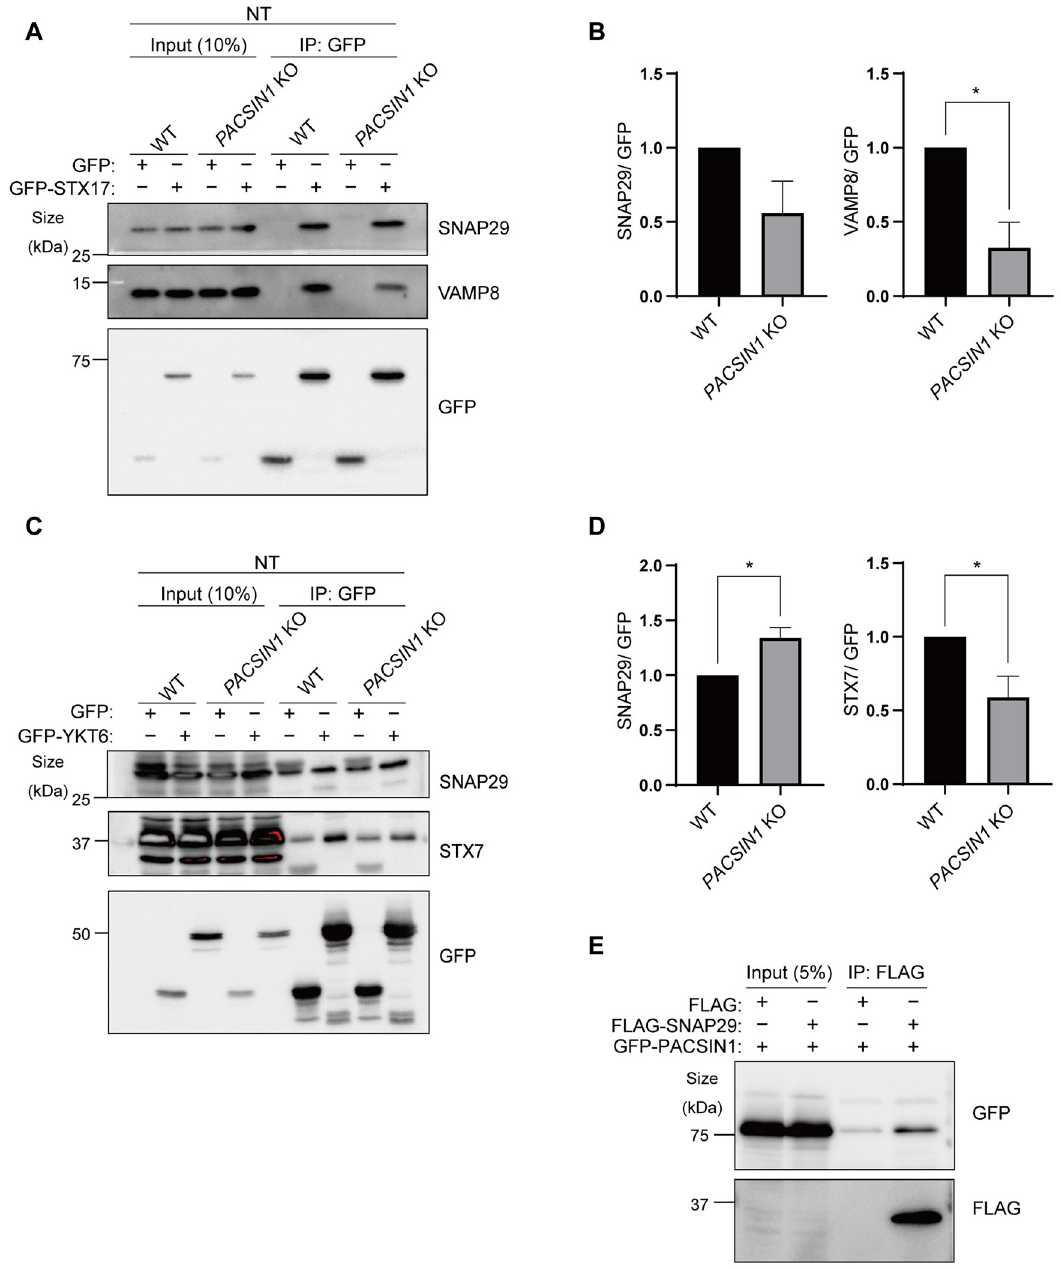
Fig 5. PACSIN1 is essential for assembly of SNARE complex. (A) WT or PACSIN1 KO HeLa cells were transfected with GFP-STX17. The lysates were immunoprecipitated with GFP-trap beads and immunoblotted with the indicated antibodies. (B) Quantification data show the amount of SNAP29 or VAMP8 normalized by GFP. Mean ± s.e.m (n = 3). � p < 0.05 (two-tailed, unpaired t-test). (C) WT or PACSIN1 KO HeLa cells were transfected with GFP-YKT6. The lysates were immunoprecipitated with GFP-trap beads and immunoblotted with the indicated antibodies. (D) Quantification data show the amount of SNAP29 or STX7 normalized by GFP. Mean ± s.e.m (n = 3). � p < 0.05 (two-tailed, unpaired t-test). (E) WT HeLa cells were transfected with FLAG-SNAP29 and GFP-PACSIN1. The lysates were immunoprecipitated with FLAG-M2 beads and immunoblotted with anti-GFP antibody.